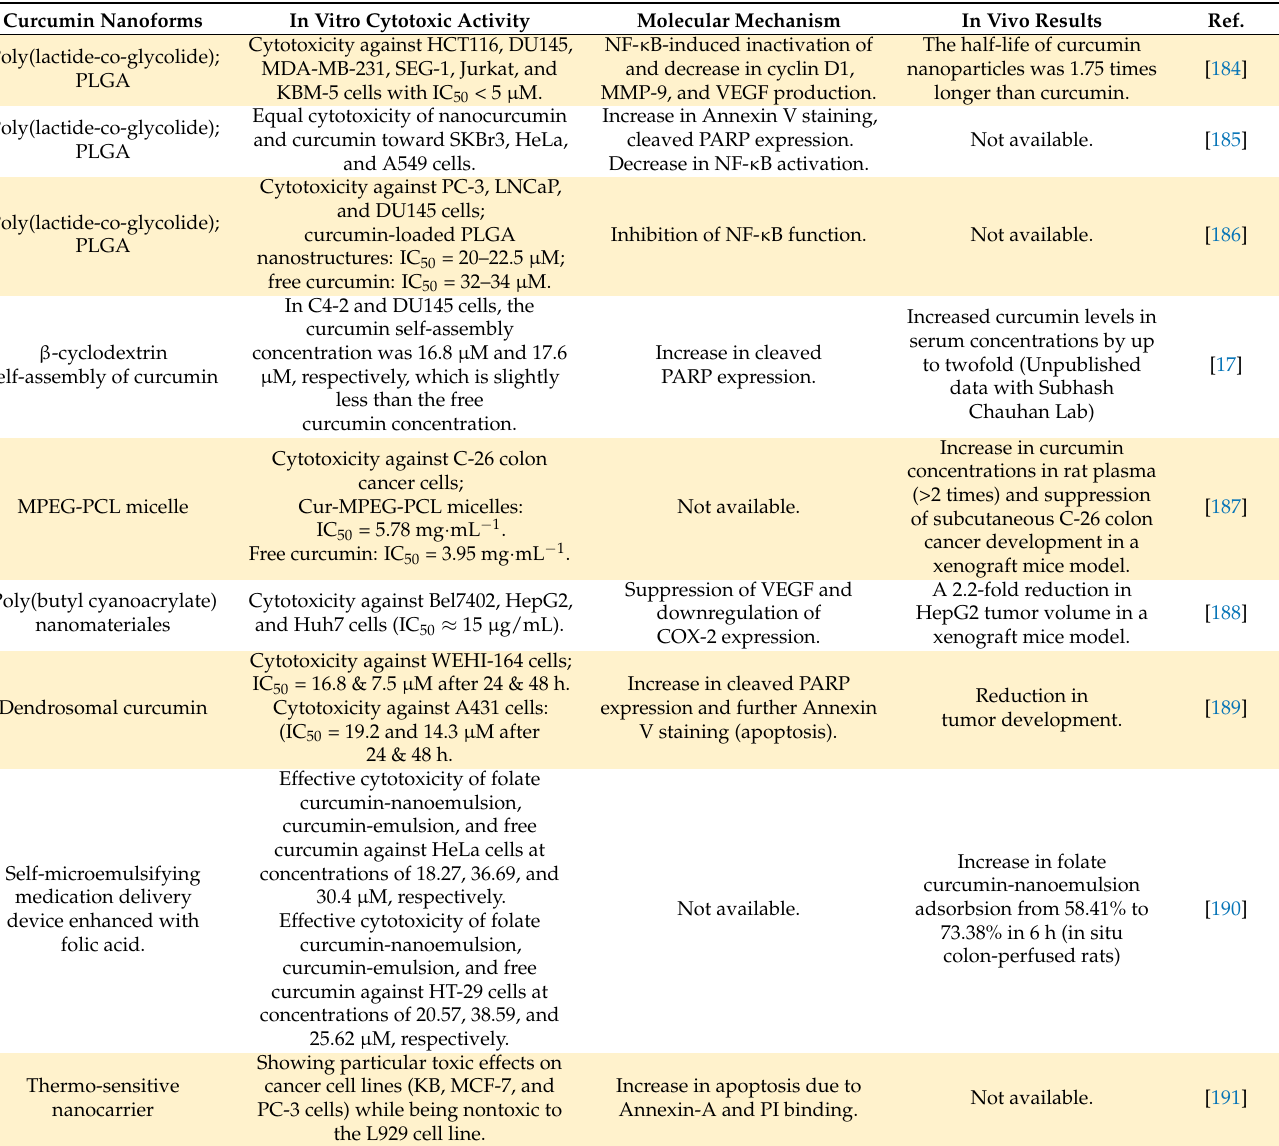
Table 1. In vivo and in vitro anticancer potential and mechanism of action of some kinds of cur- cumin